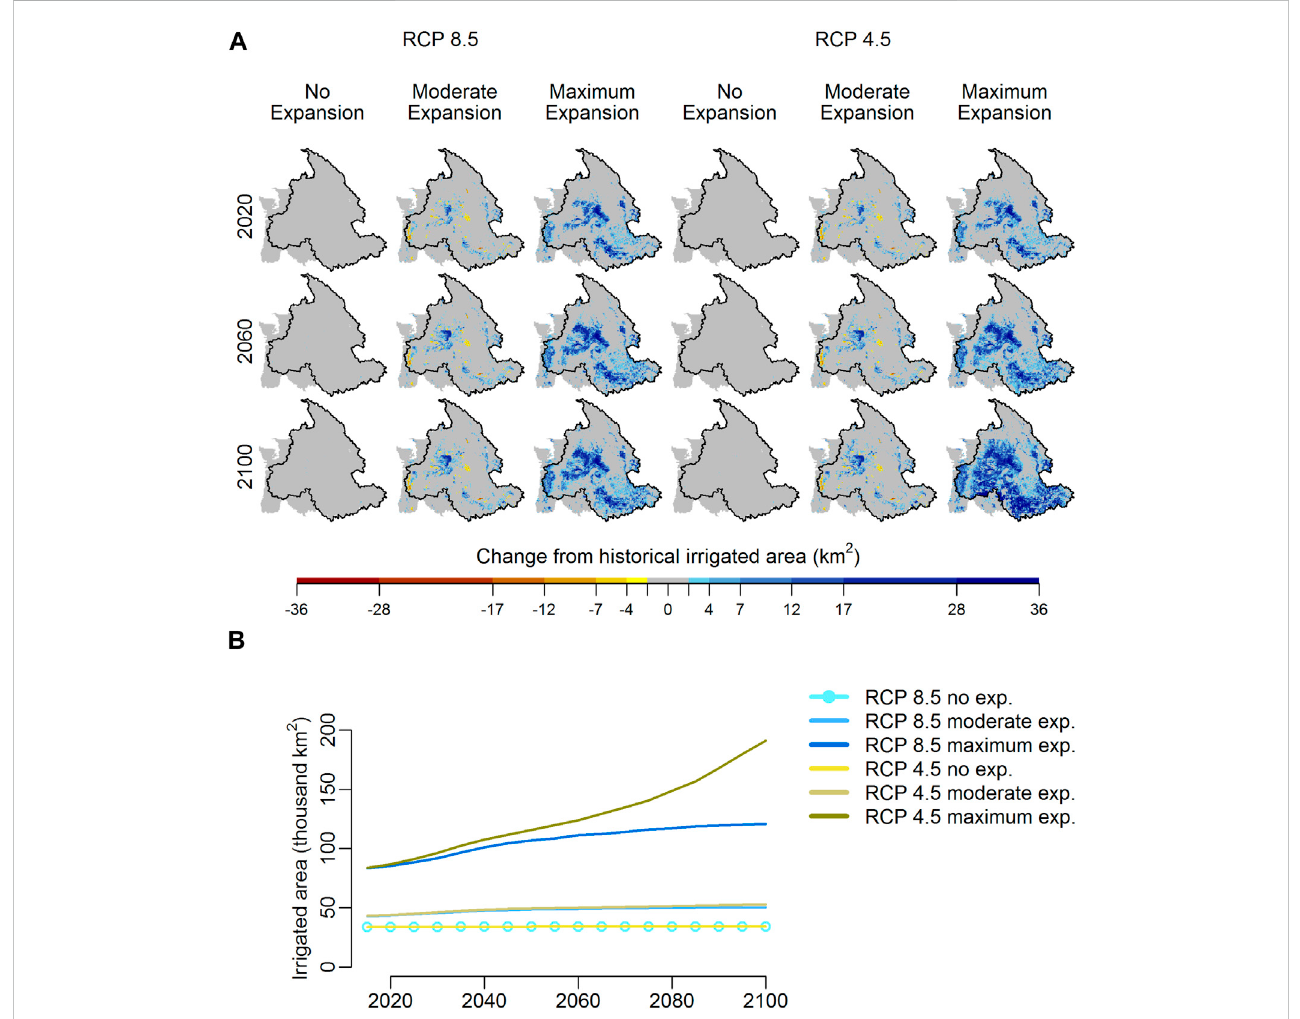
FIGURE 6 Time series of total irrigated area under RCP 4.5 and RCP 8.5 LULCC scenarios and three irrigation expansion scenarios: no expansion (2018 irrigation), moderate expansion (constrained by water right place of use), and maximum expansion (constrained by SSURGO irrigated land capability class). Panel (A) shows the spatial distributionof changes in irrigated area from contemporary irrigated extent and panel (B) gives total irrigated area over the entire study area in 5-year increments from 2015 to